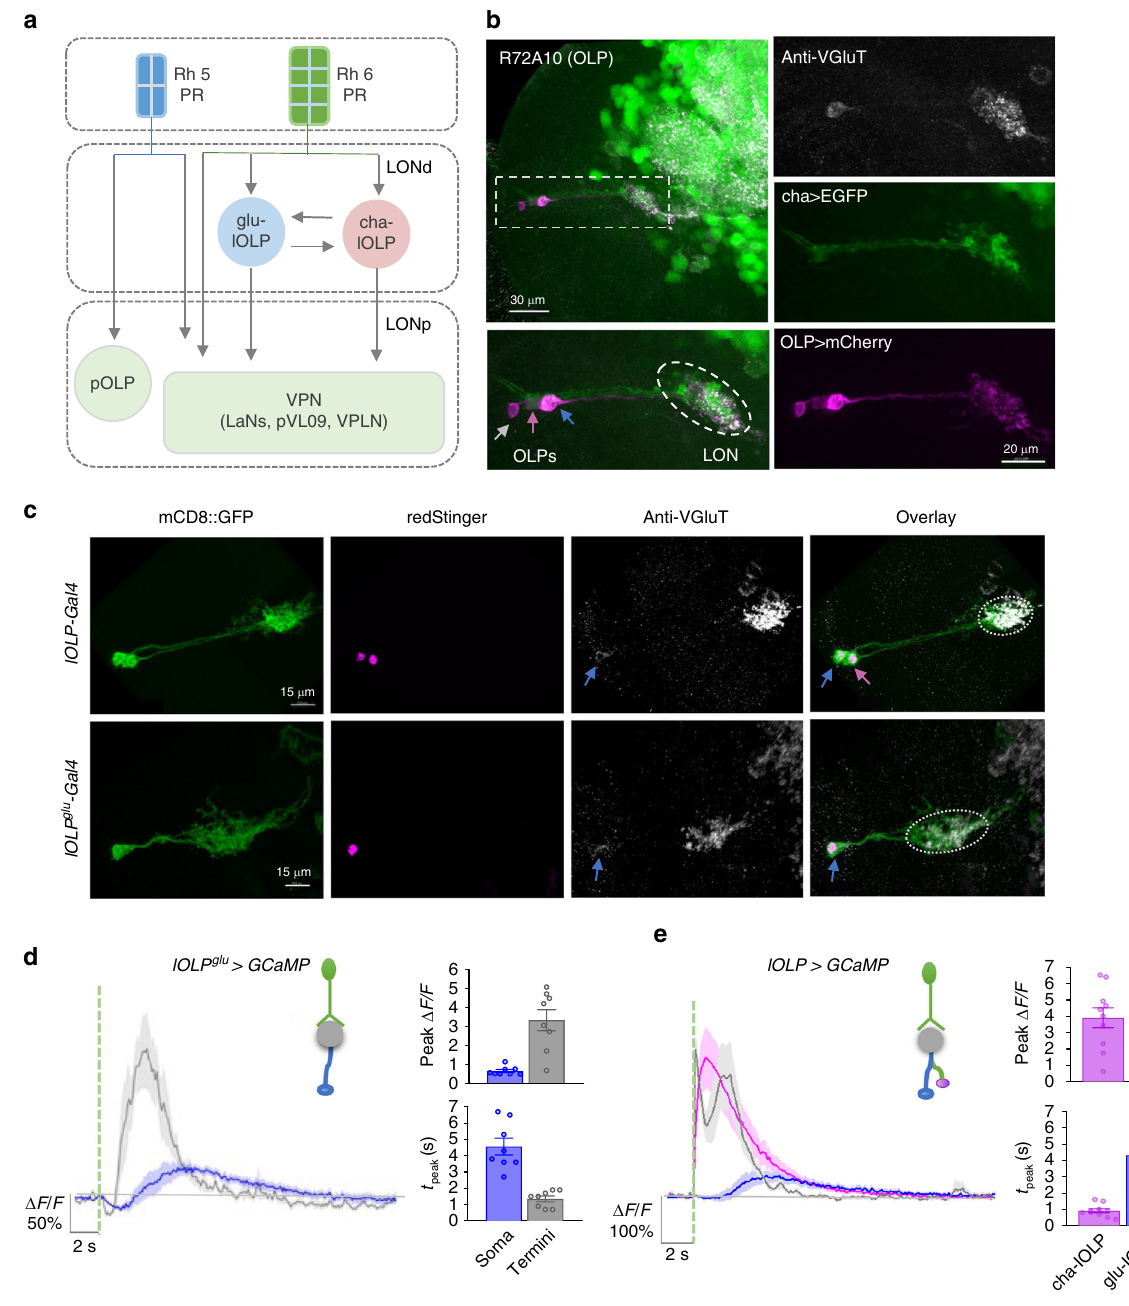
Fig. 1 Distinct light-elicited calcium responses in larval visual interneurons. a Circuit diagram of the Drosophila larval visual system. Rh5-expressing photoreceptor neurons (Rh5-PRs) project to the proximal layer of the LON (LONp) and transmit visual signals into the brain via direct synaptic connections with visual projection neurons (VPNs). Rh6-PRs project to the distal layer of the LON (LONd) and predominantly synapse onto two local interneurons, one cholinergic (cha-lOLP) and one glutamatergic (glu-lOLP), which then connect to the VPNs. Gray arrows indicate the unknown effects of light input on OLPs and most VPNs, as well as the undetermined interactions between the lOLPs. b Enhancer screens identi fi ed enhancer elements that label three OLPs. R72A10-LexA-driven LexAop-mCherry expression (magenta) reveals three somas near the lateral edge of the brain lobe, including the VGluT-positive glu- lOLP (blue arrow), the ChAT-positive cha-lOLP (pink arrow), and the projection OLP (pOLP, gray arrow). The LON region is marked by a dashed oval. c Enhancer Gal4 lines speci fi cally labeling two local OLPs (lOLP-Gal4) and the single glu-lOLP (lOLP glu -Gal4) were identi fi ed. Representative confocal images of larval brains expressing mCD8::GFP and RedStinger driven by enhancer Gal4 lines are shown. Glu-lOLP is positive for anti-VGluT staining in the soma (blue arrows) and terminal processes (dashed circles) that project to the LON. Scale bars = 15 μ m. d , e Calcium imaging experiments reveal differential physiological responses to light in two lOLPs. d Delayed calcium transients in glu-lOLP are observed using lOLP glu -Gal4 driving GCaMP6f. The calcium transients obtained at the terminal region (termini) show reduced latency and increased amplitude compared to the ones from the soma. n = 8. e Light pulses induce fast calcium transients in cha-lOLP (magenta) and slow transients in glu-lOLP (blue). The calcium transient generated at the terminal region is in gray. The average traces of GCaMP6f driven by lOLP-Gal4 and the quanti fi cations of peak value and peak time of changed intensity ( Δ F / F ) are shown. n = 10. The dashed green line represents a 100 ms light pulse at 561 nm. Shaded areas on traces and error bars on quanti fi cations represent